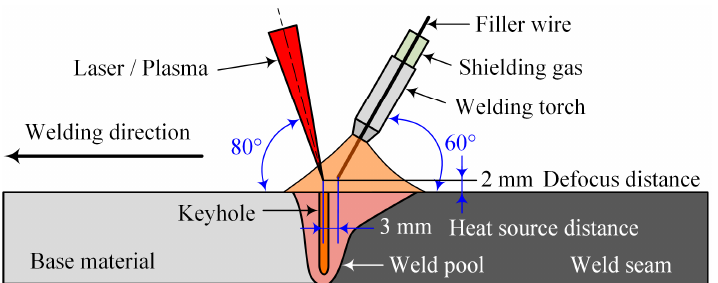
Figure 2. Schematic diagram for experimental setup (not to scale).